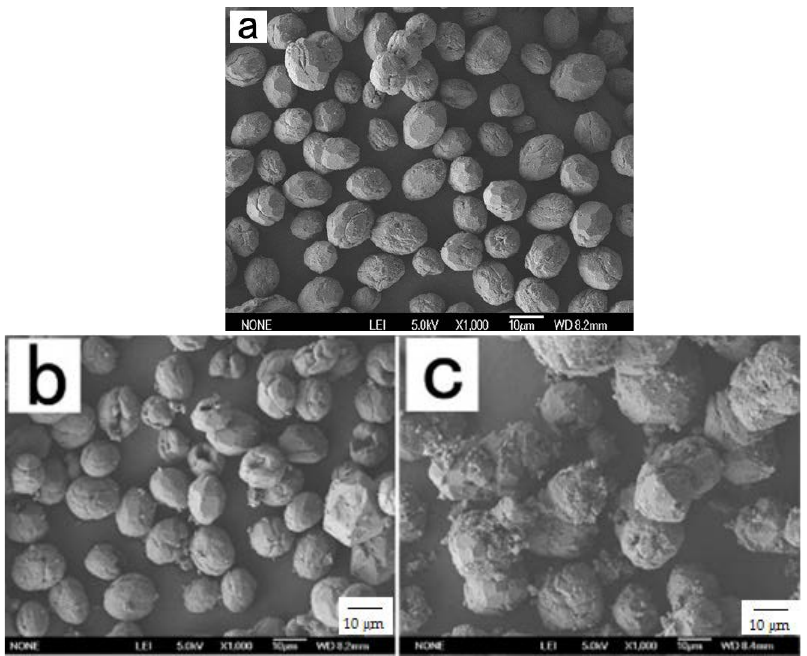
Figure 2. Scanning electron microscope (SEM) pictures of ZnAlPO 4 catalysts: ( a ) ZnAlPO 4 (0.04); ( b ) ZnAlPO 4 (0.05); and ( c ) ZnAlPO 4 (0.15).